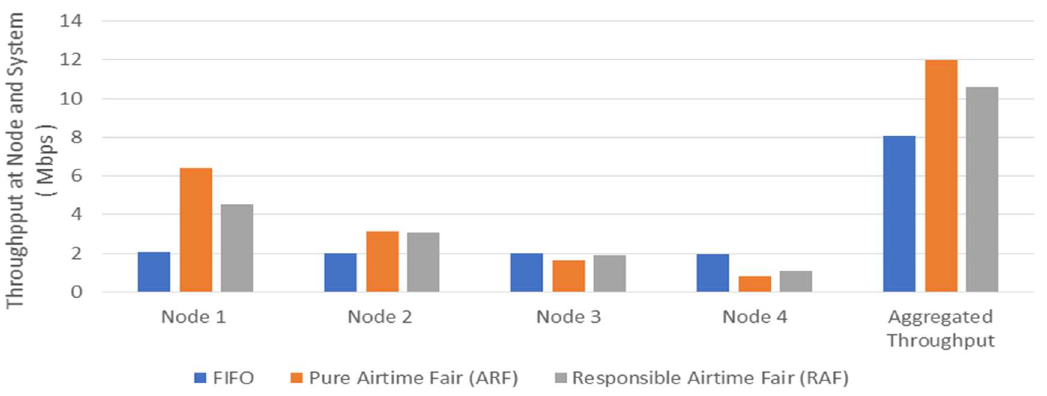
Figure 5. Throughput Performance in Fair Scheduling.